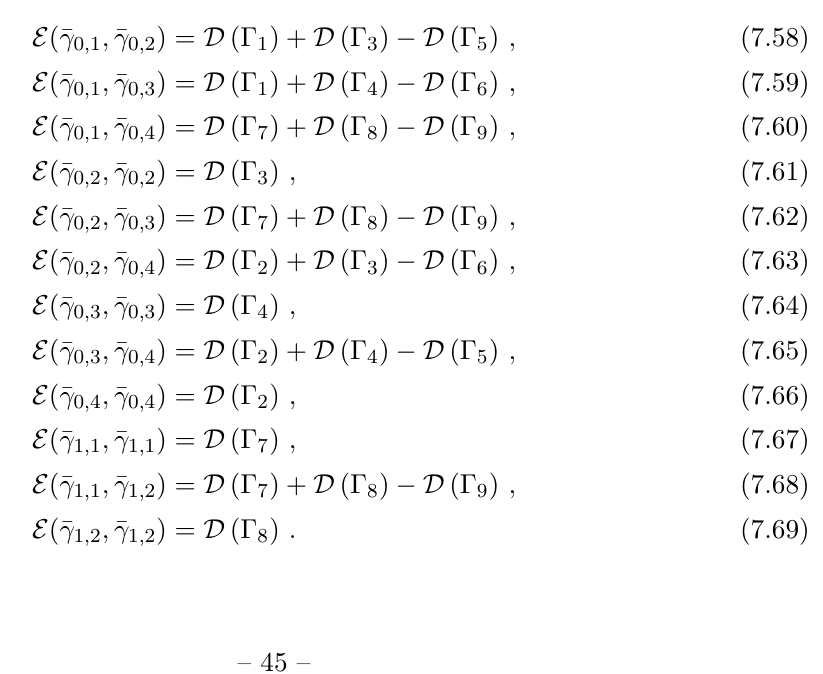
Figure 3 . Dipole graphs for q ¯ q → q 0 ¯ q 0 g . In the cases of Γ 7 , Γ 8 , and Γ 9 the self-connected gluon is also